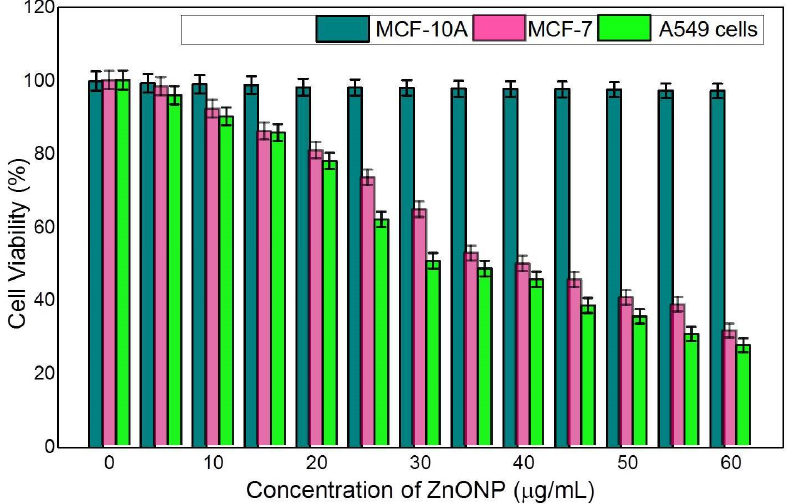
Figure 11. Cytotoxicity activity of ZnONP in MCF-10A, MCF-7 and A549 cell lines.